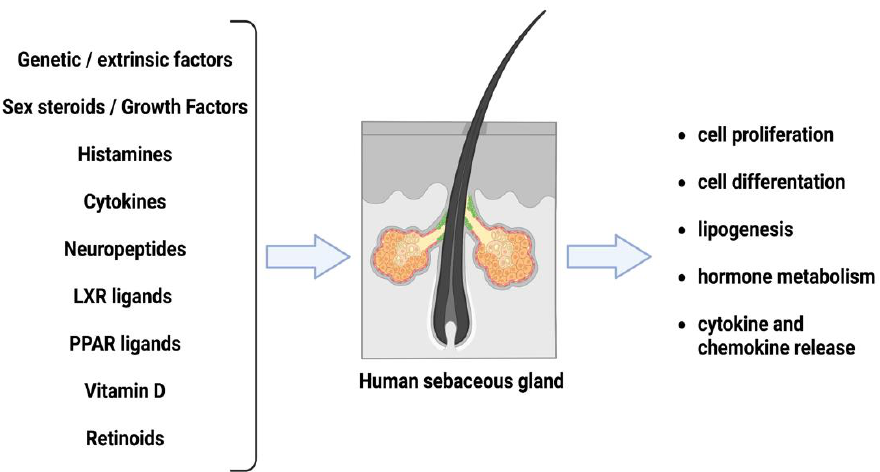
Figure 1. Regulation of the biological function of human sebaceous gland cells. The biological process of sebocyte holocrine secretion is regulated by several factors, including the ligands of the expressed receptors, such as androgens and estrogens, peroxisome proliferator-activated receptors (PPAR) ligands, neuropeptides, liver X receptor ligands (LXR), histamines, retinoids and vitamin D. The ligand-receptor complexes activate the pathways involving cell proliferation, differentiation, lipogenesis, hormone metabolism and cytokine and chemokine release.